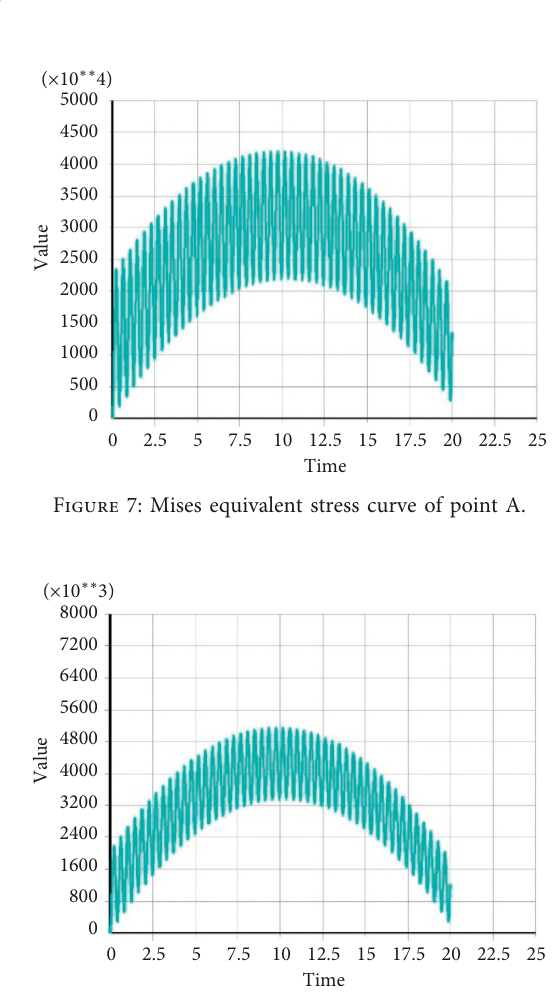
Figure 8: Mises equivalent stress curve of point